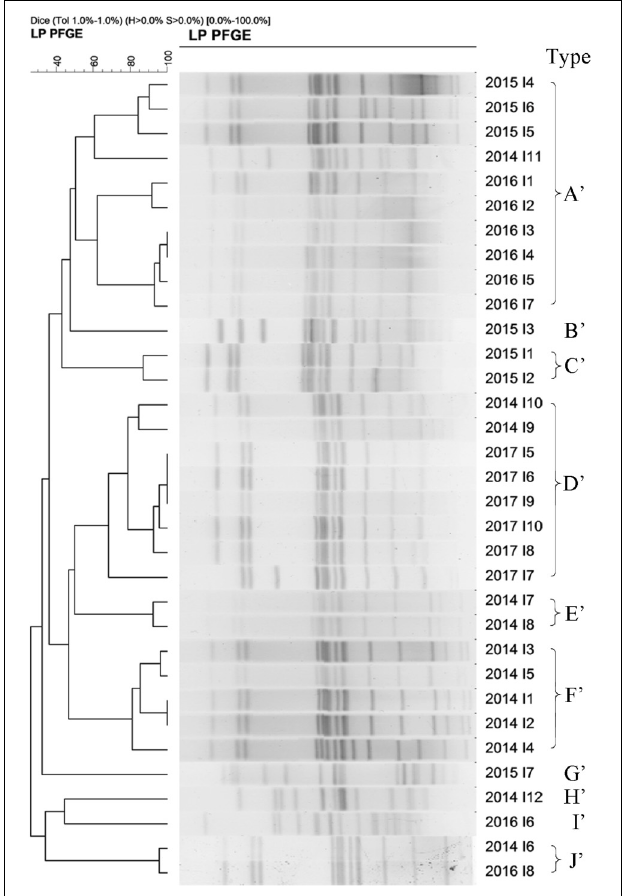
FIGURE 5 | The 33 S. Enteritidis strains collected from 2014 to 2017 were classify into 9 types (named A’–J’ ) based on a > 60% similarity.